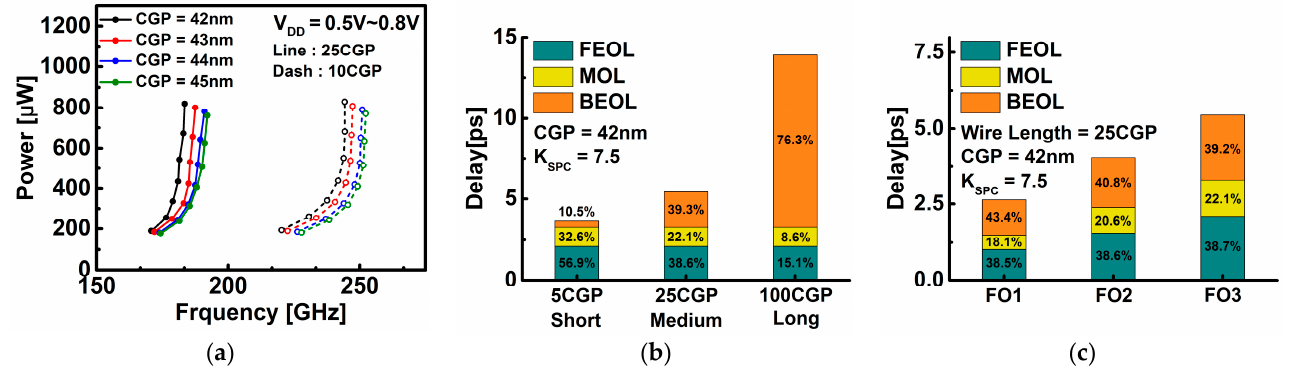
Figure 8. ( a ) Power versus frequency for DG WS 2 -FET according to CGP due to changes in L SPC with BEOL load (K SPC = 7.5). The wire length is 25 CGP, 10 CGP. ( b ) Analysis of delay of designed inverter ring oscillator with BEOL load. The wire length was considered in three cases (5 CGP, 25 CGP, and 100 CGP) in the BEOL load. ( c ) Analysis of delay of designed inverter ring oscillator with BEOL considering fan-out dependency.